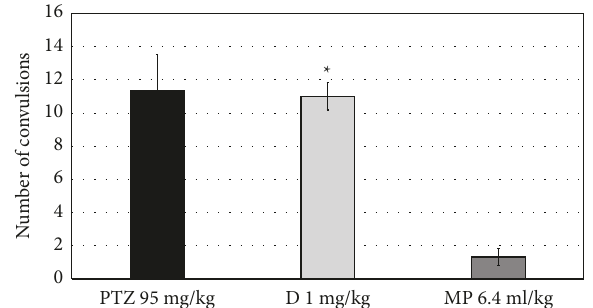
Figure 6: Effects of MPO (6.4ml/kg) on the number of convulsions in PTZ-induced epilepsy model in mice, ∗ P < 0 . 5 when compared to the PTZ group. PTZ: pentylenetetrazol, D: diazepam, MP: Mentha piperita L . oil.